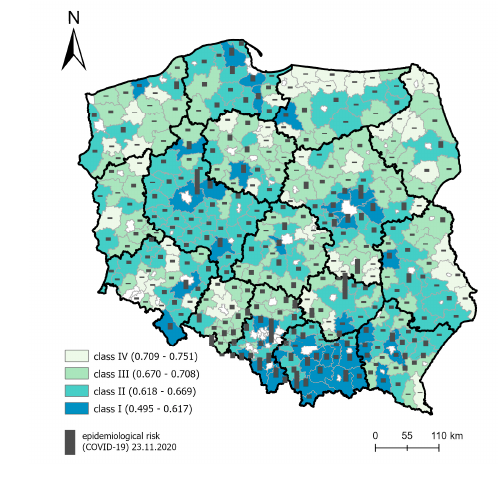
Figure 9. Dependency/relationship between the classification of areas (summary synthetic index WO) and epidemiological risk (number of cases) (COVID-19)—first pandemic wave. Source: own elaboration.